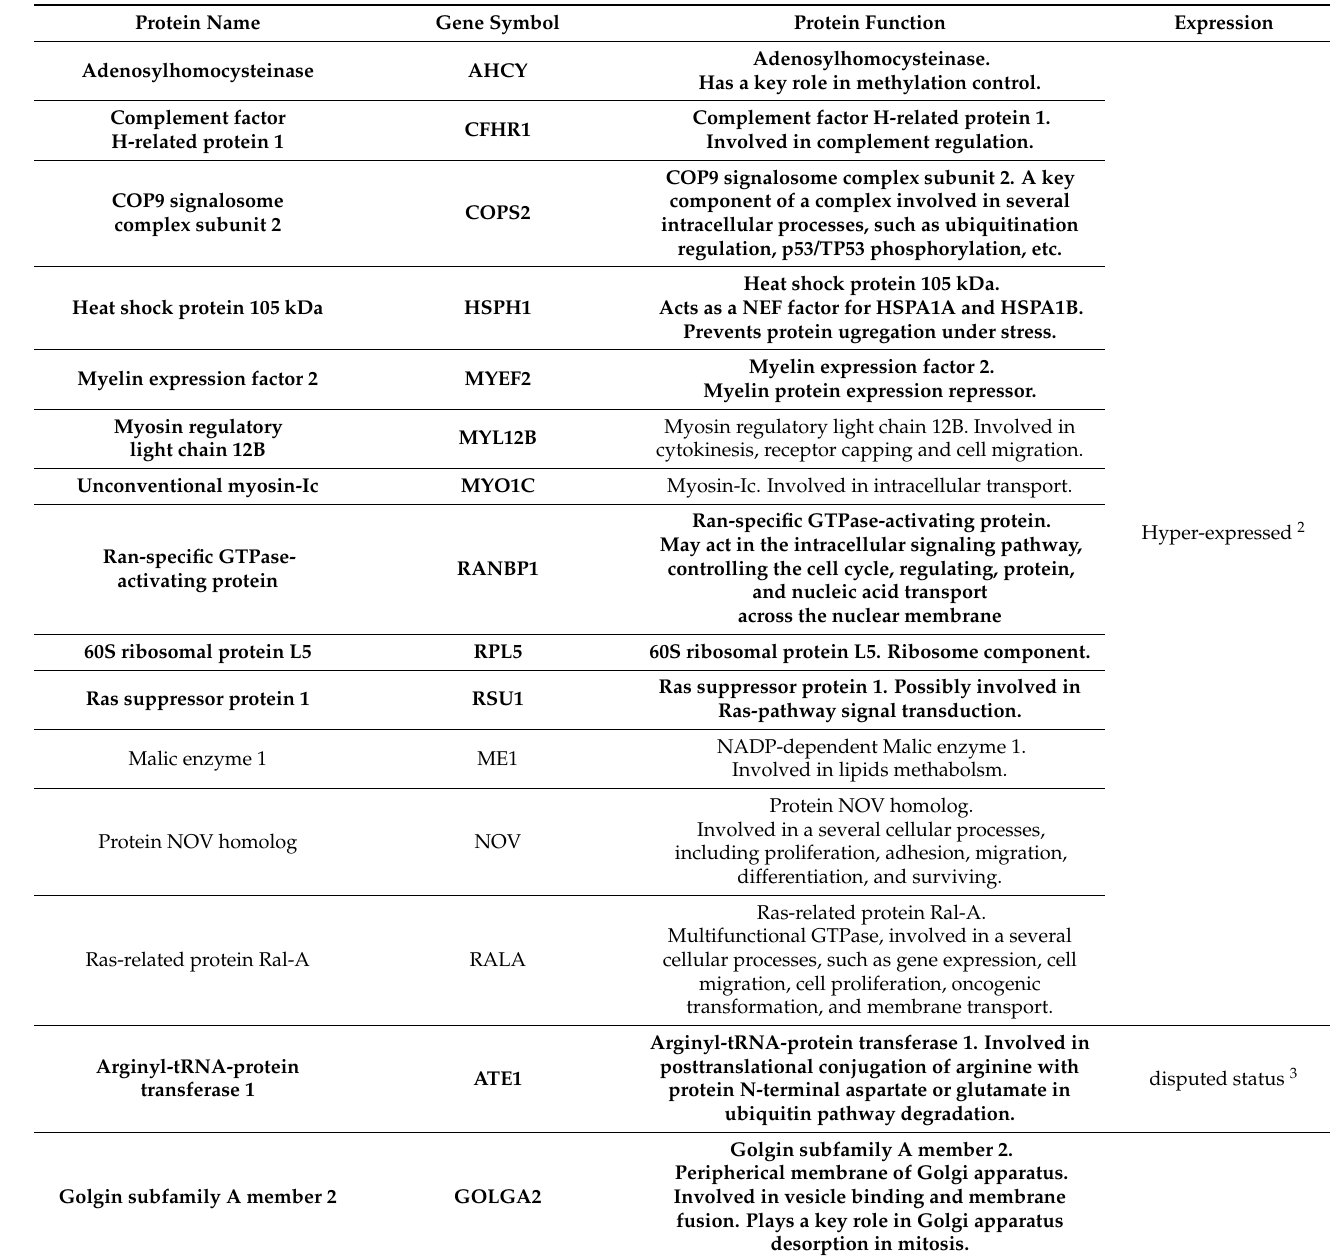
Table 1. Identified using dbDEPC 3.0, NPC proteins in the BCP blood, differentially expressed in breast cancer 1